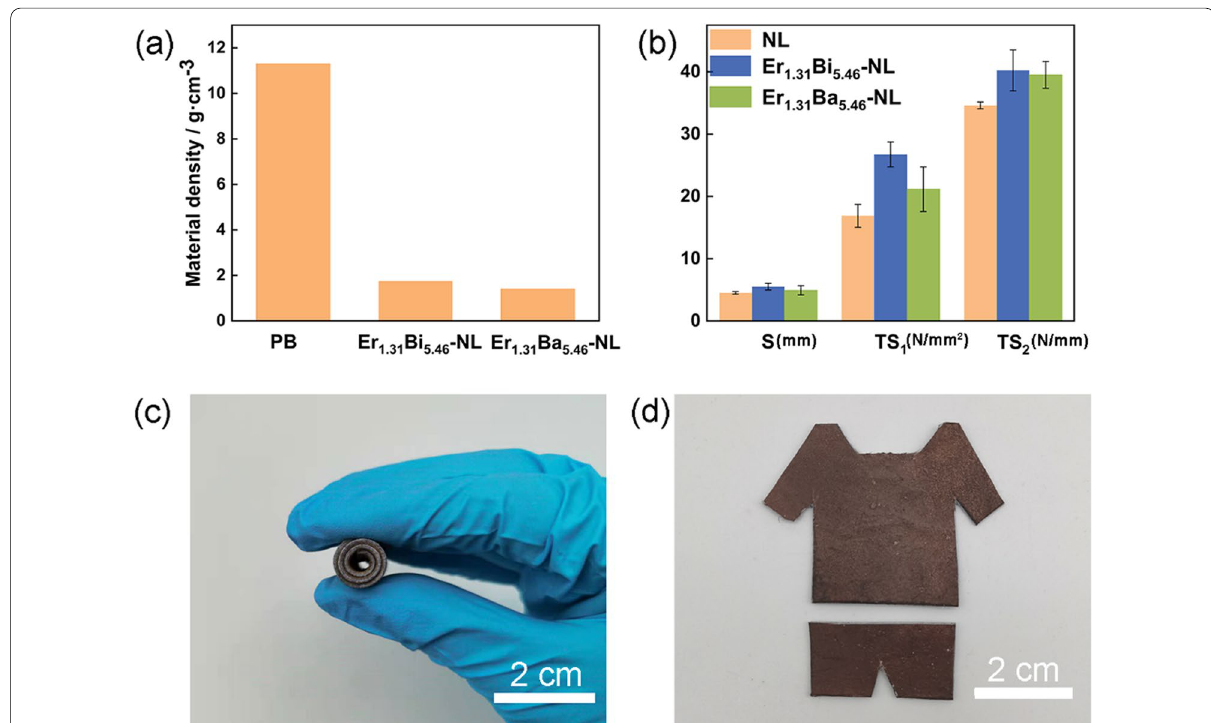
Fig. 4 a Density of Pb-B, Er 1.31 Z 5.46 -NL and Pb-B; b mechanical strength of the NL and Er 1.31 Z 5.46 -NL (S, TS1 and TS2 represent softness, tensile strength, and tear strength, respectively); c flexibility of